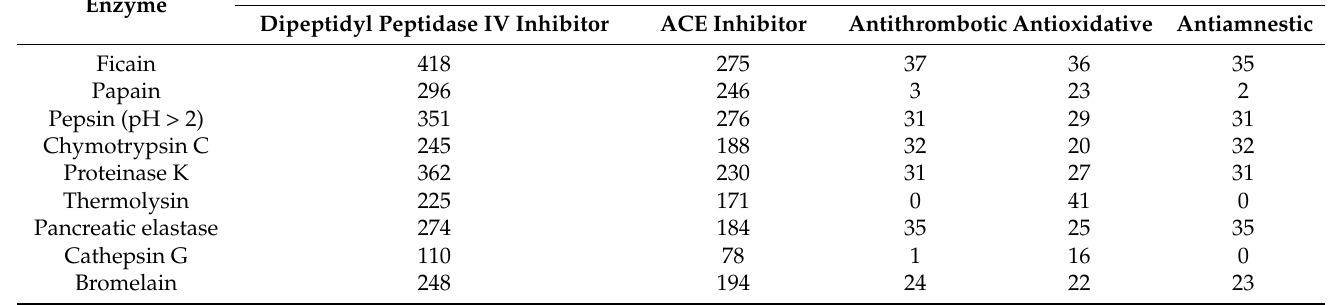
Table 4. Numbers of potential bioactive peptide released from mackerel steaming juice (MSJ) proteins